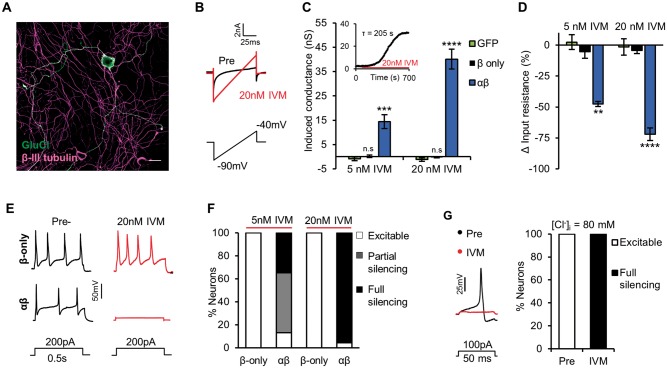

GluCl activation silences electrical activity of DRG neurons in vitro. Whole-cell patch clamp recordings of DRG neurons electroporated with GluClα/β-YFP. (A) GluCl+ DRG neuron. Scale bar = 30 µm. (B) Voltage ramp used to determine membrane conductance. Ivermectin (IVM, 20 nM) treatment induces a membrane conductance in GluCl+ DRG, as seen by the increased slope of the current trace. (C) Induced conductance in response to ivermectin. (Inset) Example recording of ivermectin-conductance over time. One-way ANOVA with post hoc Bonferroni test comparing groups to control (GFP), GFP 5 nM ivermectin n = 10, GFP 20 nM ivermectin n = 10, β-only 5 nM ivermectin n = 11, β-only 20 nM ivermectin n = 15, αβ 5 nM ivermectin n = 24 and αβ 20 nM ivermectin n = 24. (D) Change in input resistance following ivermectin. One-way ANOVA with post hoc Bonferroni test comparing groups to control (GFP), GFP 5 nM ivermectin n = 10, GFP 20 nM ivermectin n = 10, β-only 5 nM ivermectin n = 11, β-only 20 nM ivermectin n = 15, αβ 5 nM ivermectin n = 24 and αβ 20 nM ivermectin n = 24. (E) Firing of neurons in response to supra-threshold current injection pre- and post-ivermectin treatment. (F) Ability of GluCl+ neurons to fire an action potential in response to a short (50 ms) depolarizing current. Neuronal excitability was defined by the fold-increase in rheobase comparing pre- and post-ivermectin values: <3 (excitable), 3–10 (partial silencing) or >10-fold (full silencing). P < 0.001, chi-squared test (χ2 = 55.74 with 4 degrees of freedom). β-only 5 nM ivermectin n = 11, β-only 20 nM ivermectin n = 15, αβ 5 nM ivermectin n = 24 and αβ 20 nM ivermectin n = 24. (G) Excitability of GluCl+ DRG assessed while using an intracellular solution containing 80 mM Cl−. (Left) Example firing of a GluCl+ neuron in response to supra-threshold current stimuli pre- and post-ivermectin (20 nM). (Right) Following ivermectin, 5/5 neurons were unable to fire an action potential in response to a current 10-fold their pre-drug rheobase value (full silencing). All grouped data are mean ± SEM, *P < 0.05, **P < 0.01, ***P < 0.001; P < 0.0001.